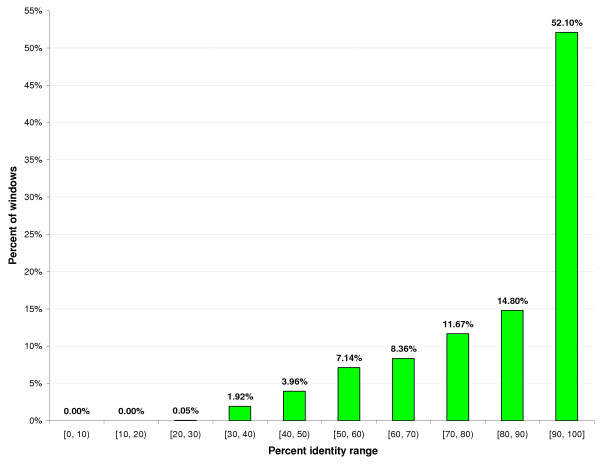
Distribution of scanning window percent identities in the MUMmer whole genome ncRNA screen. Histogram showing the distribution of percent identities of 15,214 genomic windows (size 150 alignment columns, scanning step size 75 alignment columns), generated from the MUMmer whole genome alignment of E. coli and S. typhi.